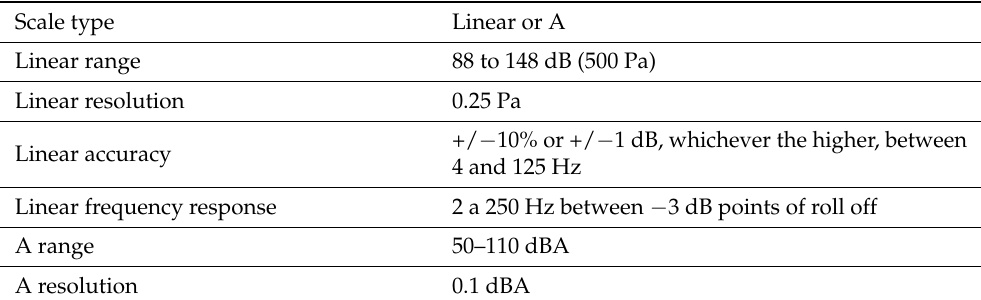
Table 1. Instantel linear microphone characteristics used to measure air overpressure.